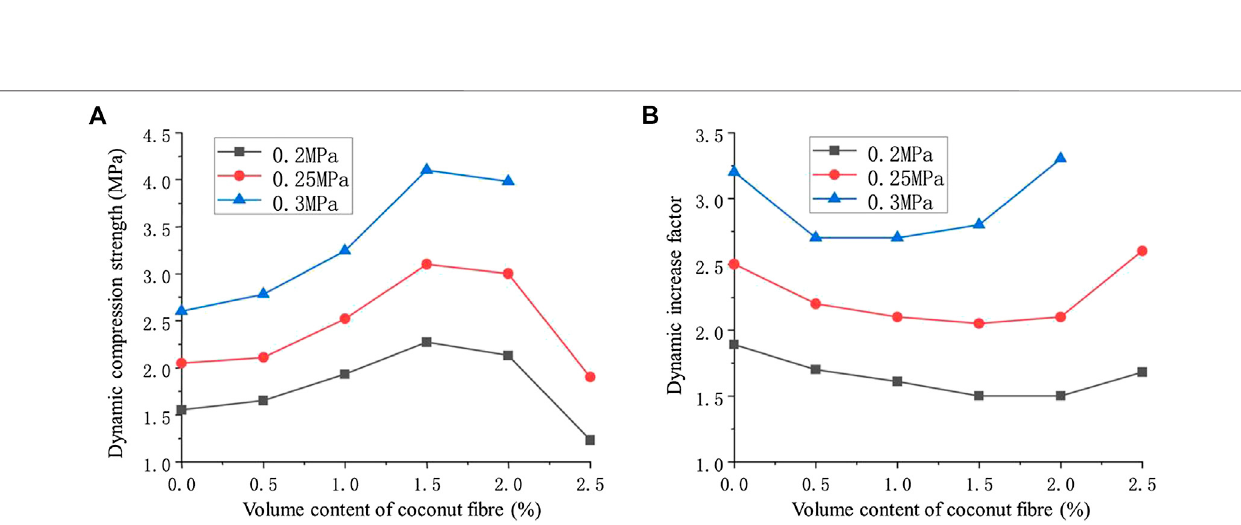
FIGURE 6 | Failure modes at the gas pressure of 0.3 MPa (A) CF0.0-AP0.30-3 (B) CF0.5-AP0.30-3 (C) CF1.0-AP0.30-2 (D) CF1.5-AP0.30-1 (E) CF2.0-AP0.30-3.